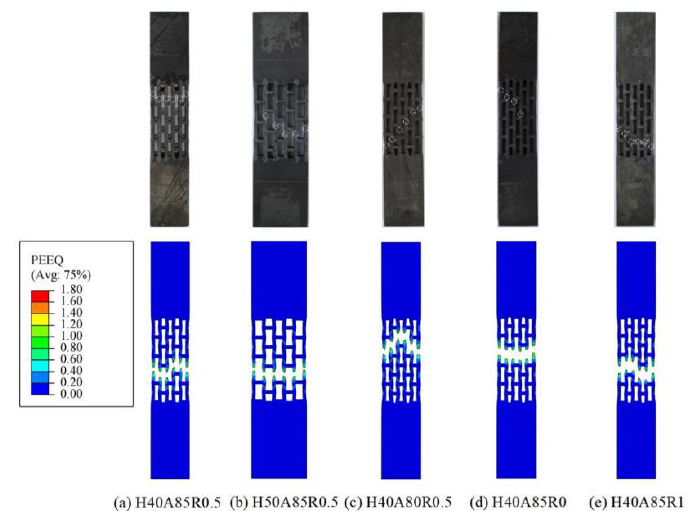
Figure 8. Comparison of failure modes with ( a ) H40A85R0.5, ( b ) H50A85R0.5, ( c ) H40A80R0.5, ( d ) H40A85R0 and ( e ) H40A85R1.